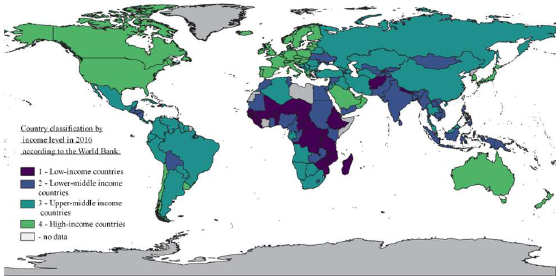
Fig. 1. Country classification by income level in 2016 by applying QGIS version 3.4.3